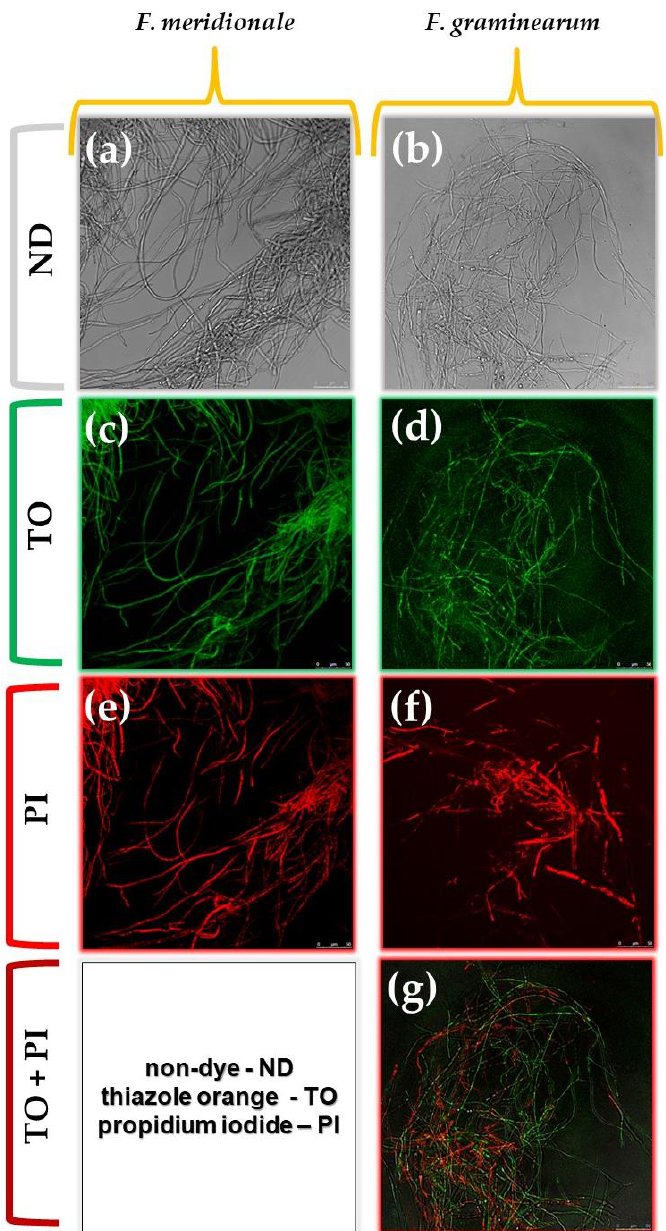
Figure 5. Confocal microscopy images of F. meridionale (FML03) and F. graminearum (FML08) treated by GAPJ for 15 min (40× magnitude): ( a , b ) without dye; ( c , d ) with thiazole orange (green color); ( e , f ) with propidium iodide (red color); and ( g ) with TO + PI.